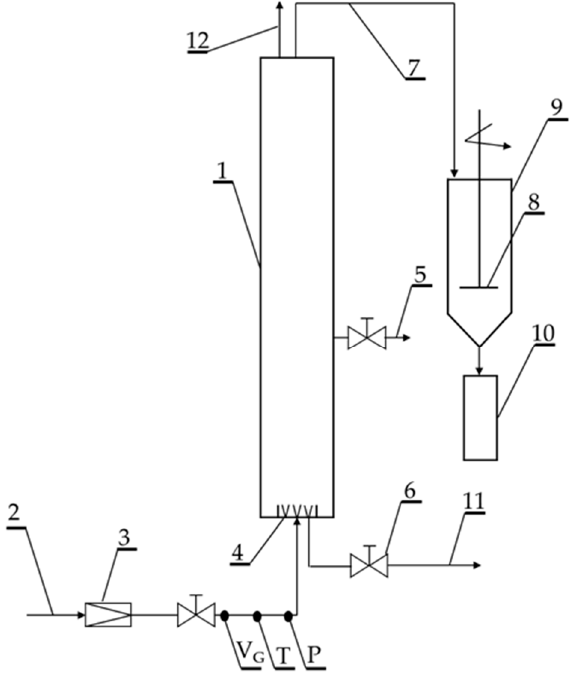
Figure 1. Scheme of a laboratory set-up: 1—bubble flotation column; 2—compressed air line; 3—pressure reduction valve for compressed air; 4—ceramic porous sinter; 5—sampling port for liquid; 6—drainage valve; 7—foam line; 8—rotating horizontal plate; 9—foam container; 10—foam condensate container; 11—waste solution line; 12—air outflow.